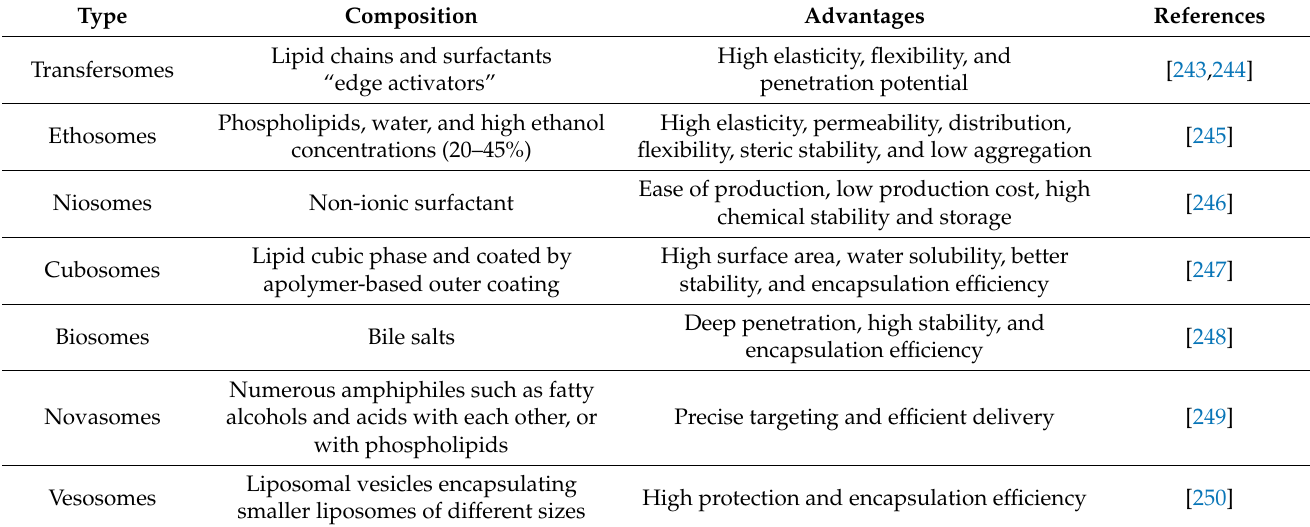
Table 3. Composition and characteristic features of each liposomal new